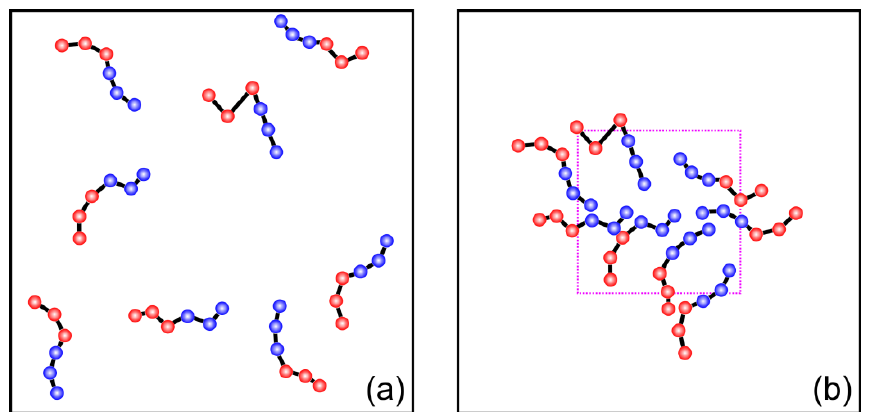
Figure 1. Schematic illustration of two types of initial system states used in this work ( a ) homogeneous initial system state and ( b ) initial system state with the solvophobic chain ends placed inside a cubic